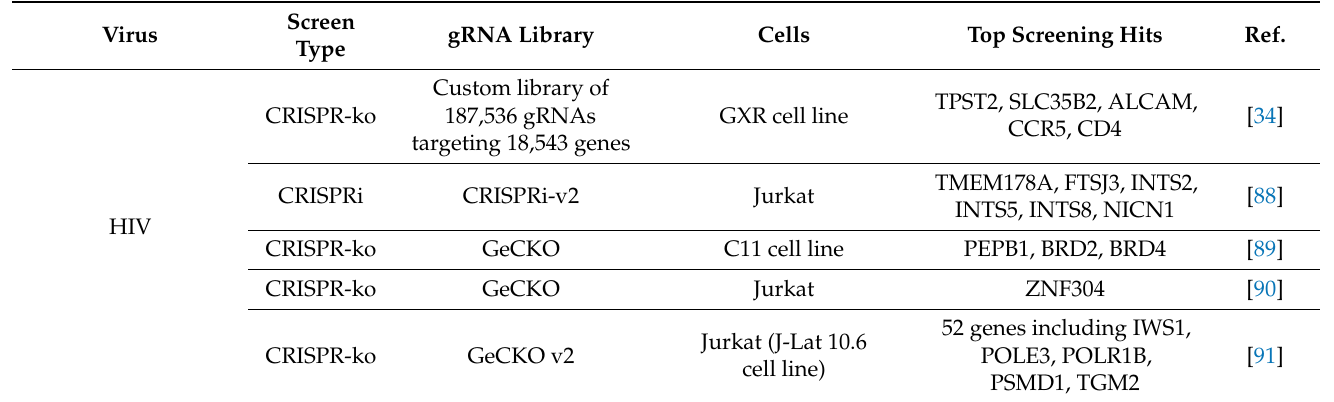
Table 2. CRISPR screens for studying viral